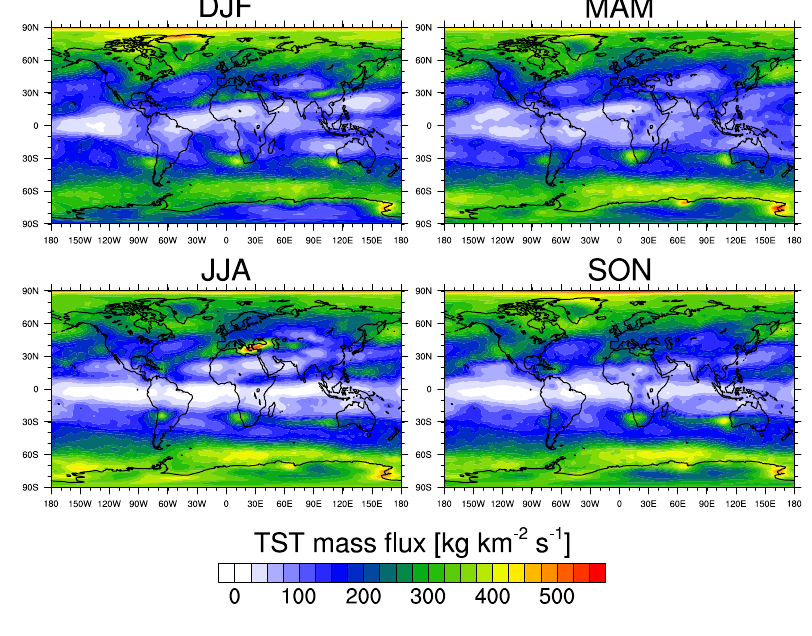
Fig. 3. Seasonally averaged TST mass flux for